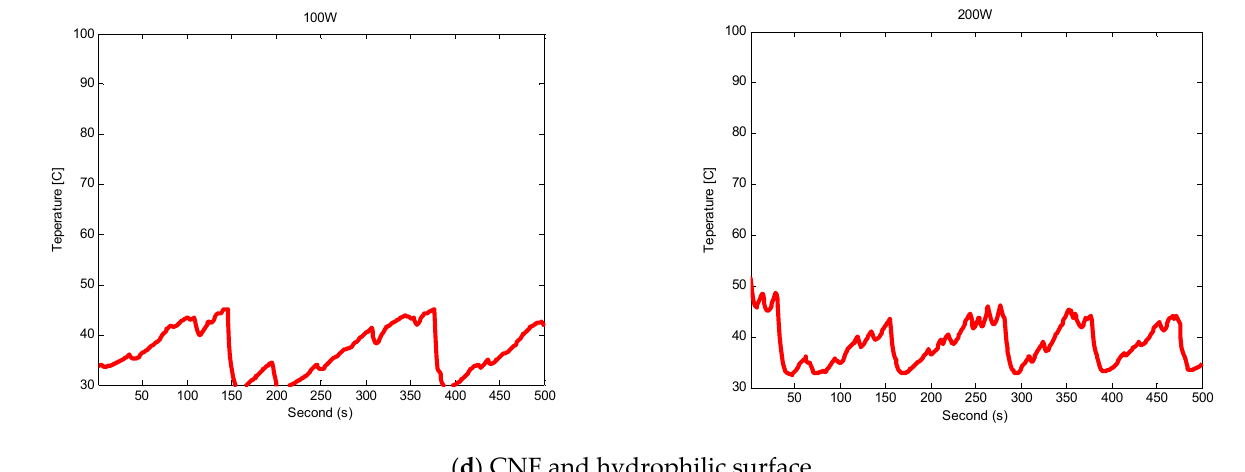
Figure 7. Evaporator wall temperature (T7) variations with time at FR 0.25. The BHTC and total thermal resistance can be calculated using the temperature dif- ference between the average temperature of the evaporator’s inner surface and the inter- nal saturation temperature. At 100 W input power, the temperature differences of cases (a)–(d) were 13.01 °C, 7.58 °C, 3.75 °C, and 2.15 °C, respectively. At 200 W input power, the temperature differences of cases (a)–(d) were 21.60 °C, 13.45 °C, 10.53 °C, and 4.81 °C, respectively. The temperature difference decreased gradually from cases (a) to (d); hence, the highest BHTC and lowest total thermal resistance are shown in (d).